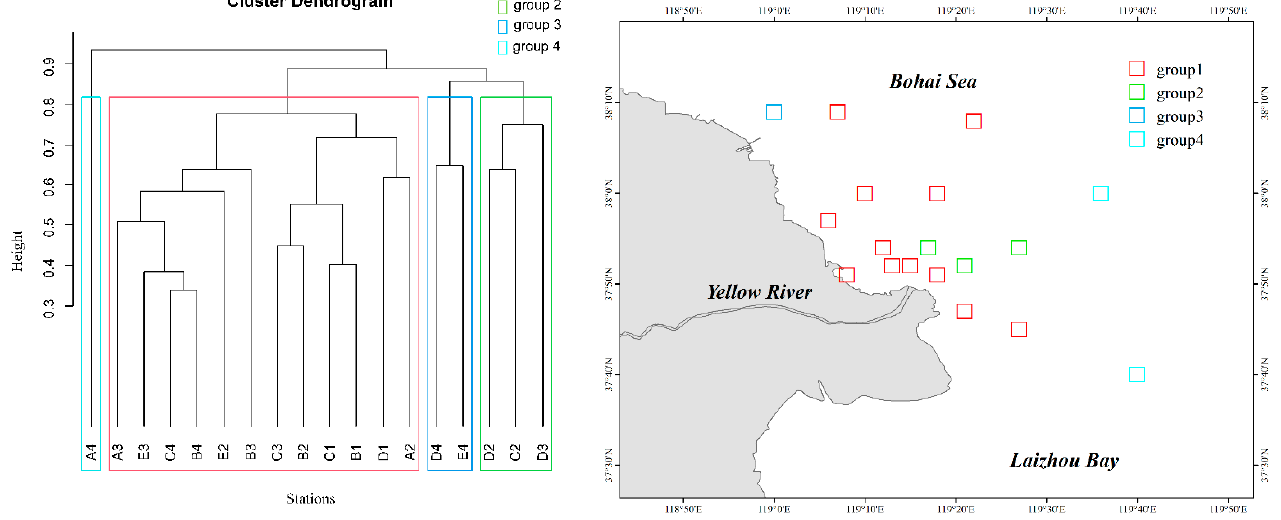
Figure 7. Species diversity index values of fish eggs and larvae collected from the Yellow River estuary in this study. a, b: the significant difference between groups.